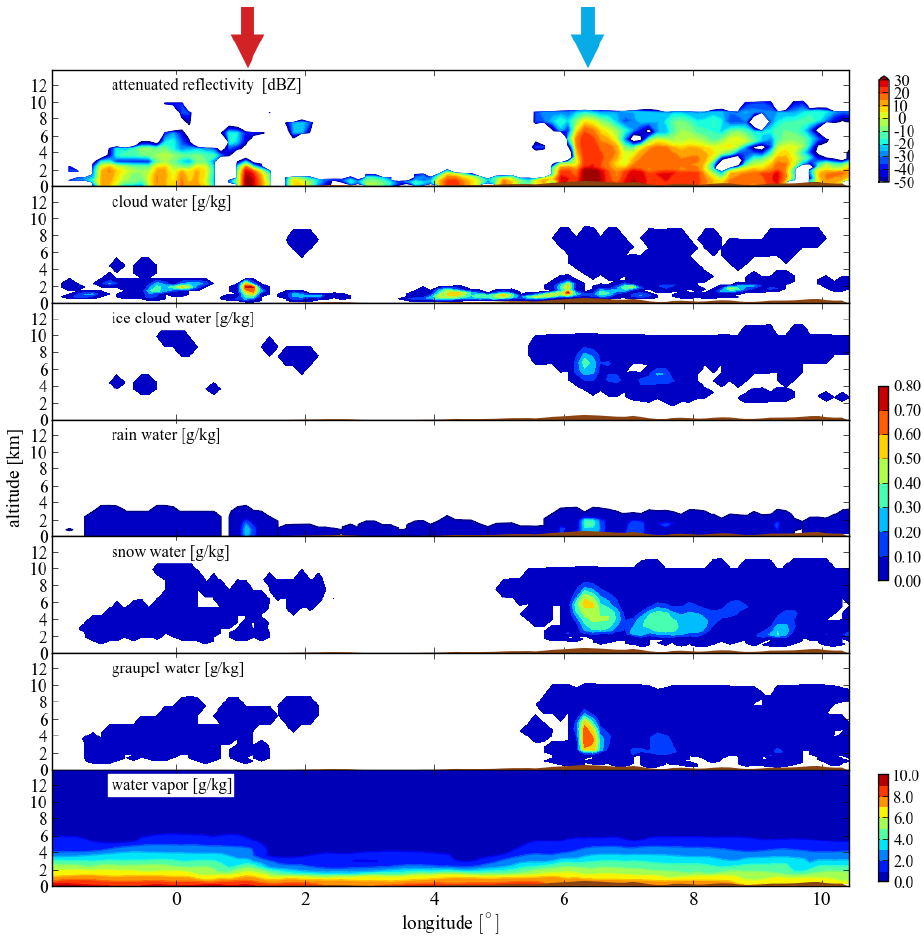
Figure 6. Attenuated reflectivities (top) and hydrometeor and water vapor contents along the same cross section as in Figs. 4 and 5.